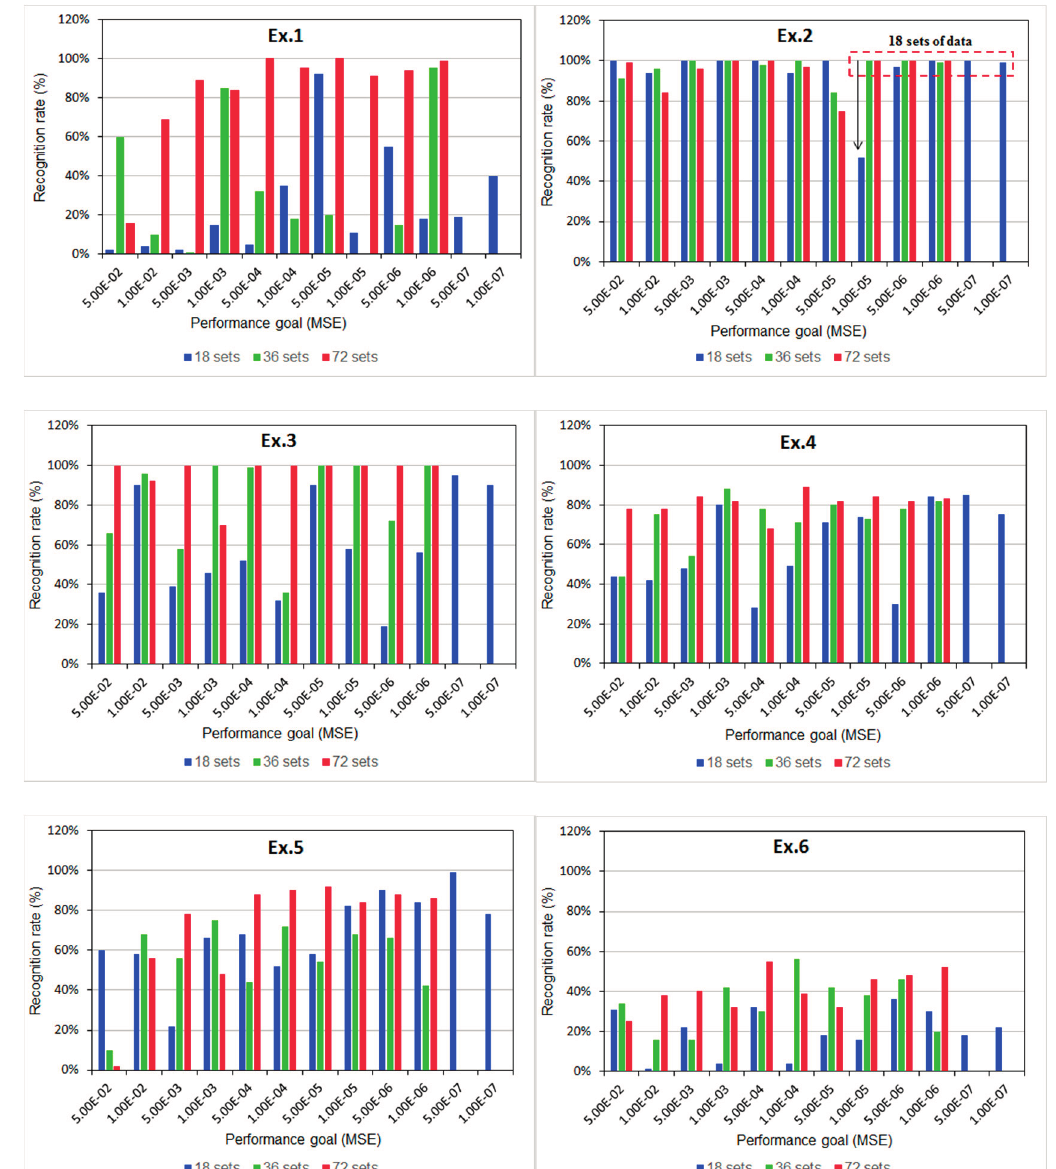
Figure 7. Recognition rates of exercises versus performance goal when various types of input data sets were used: blue ( left ) bar: 18 sets; green ( middle ) bar: 36 sets; and red ( right ) bar: 72